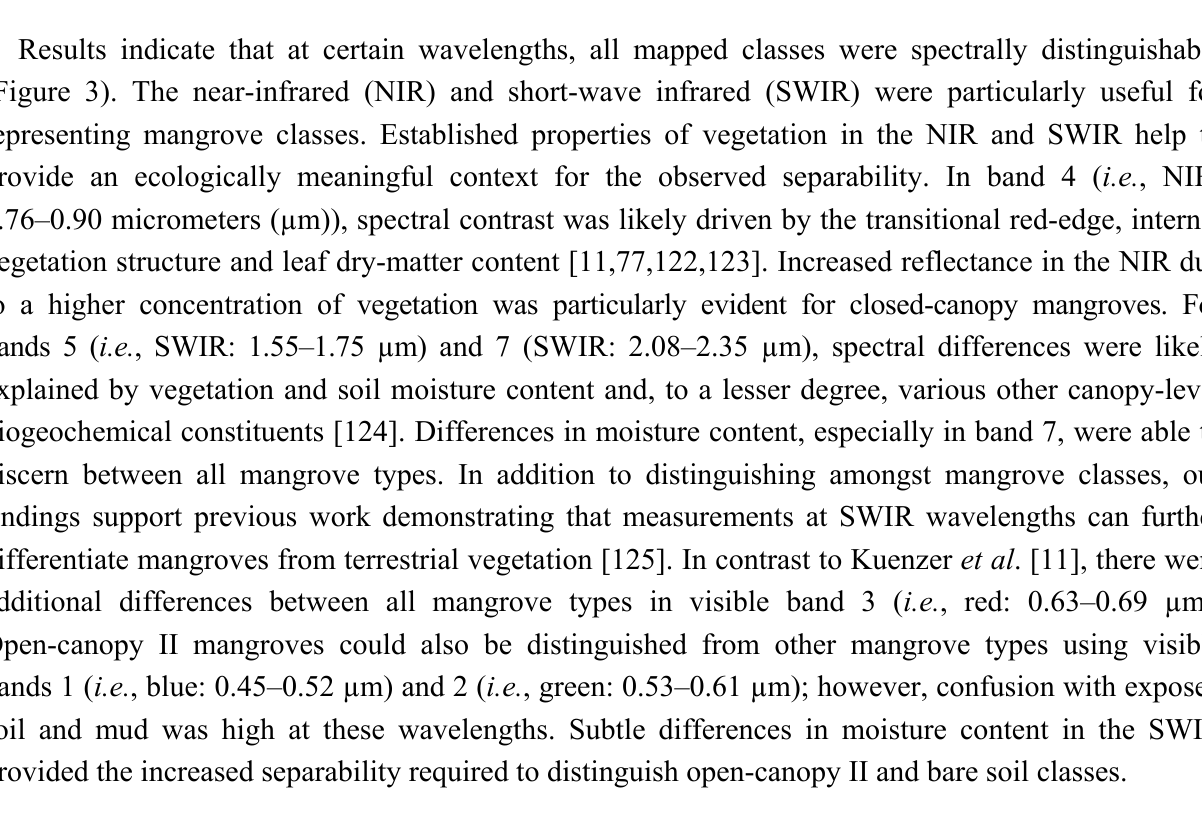
Figure 3. The mean spectral value (±1 standard deviation) of mapped